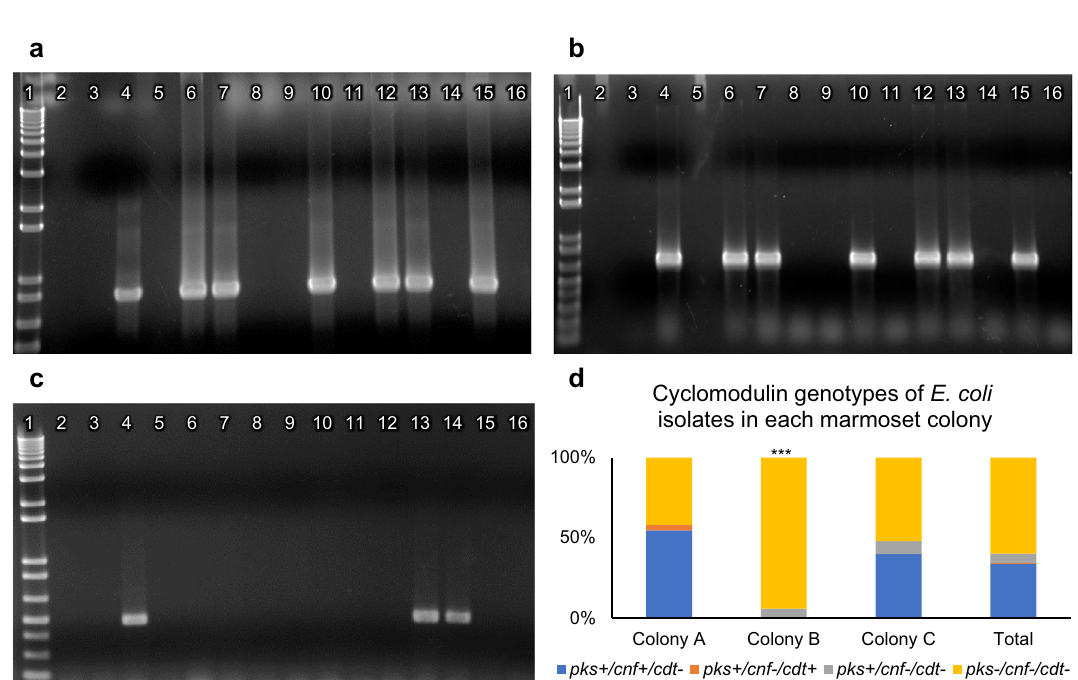
Figure 2. PCR amplification of cyclomodulin genes in representative E. coli isolates from marmosets. ( a ) Amplification of clbQ gene from pks island. ( b ) Multiplex PCR amplification was used to detect both chromosomal and plasmid cnf genes. ( c ) Multiplex PCR amplification was used to detect all known variants of the cdtB gene. PCR gels: lane 1,1-kb ladder; lane 2, blank; lane 3, negative control; lane 4, positive control; lanes 5 through 16, representative E. coli isolates from marmosets. Both cdt -positive isolates shown (lanes 13 and 14) are from the same animal. ( d ) Distribution of cyclomodulin genotypes of E. coli isolated from marmosets according to colony. Colony B had a significantly different distribution than either of the other two colonies. *** p < 0.001, Fisher’s Exact Test. Unedited images of gels are shown in Supplementary Figure